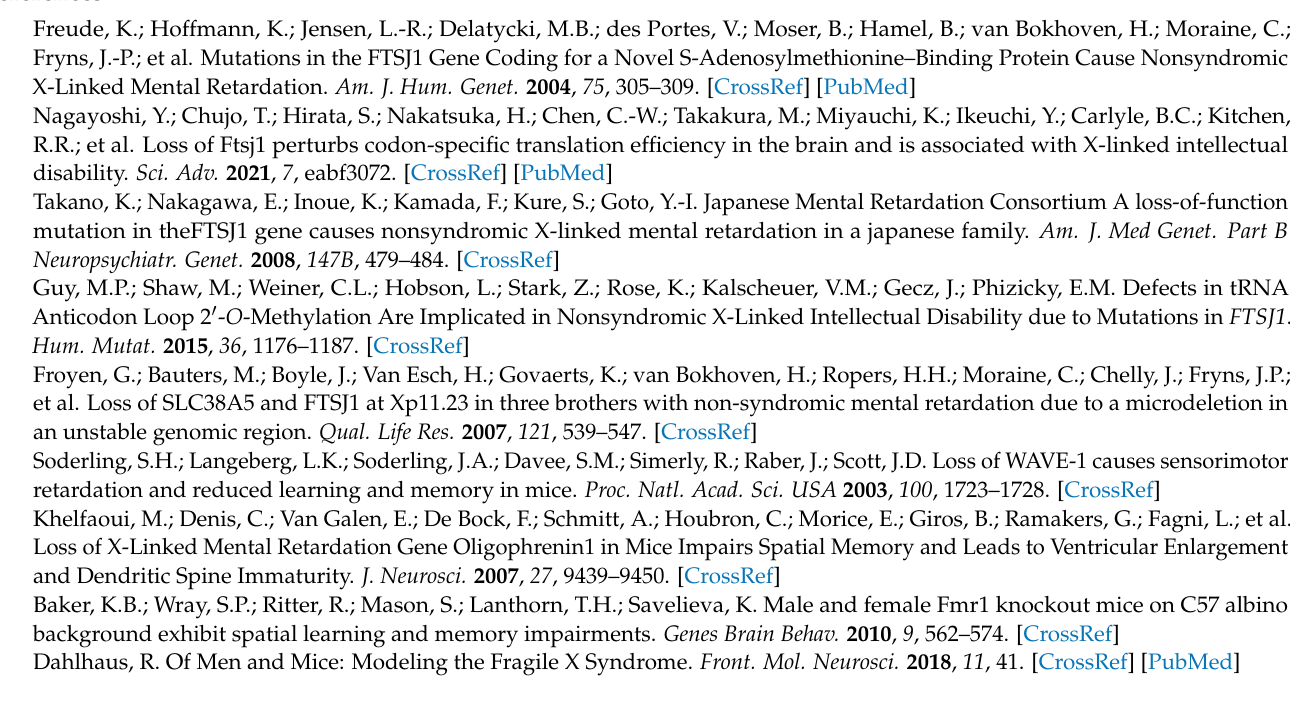
Table S2: Differentially expressed proteins identified by mass